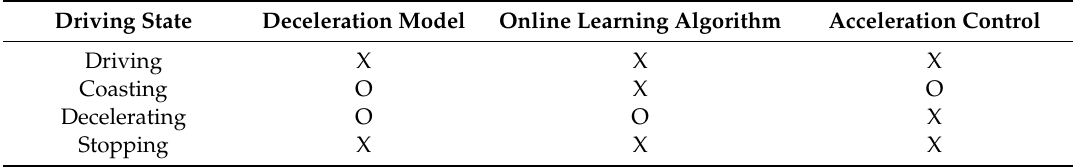
Figure 2. Flowchart of driving states. Table 1. Operability of each algorithm according to the driving state.